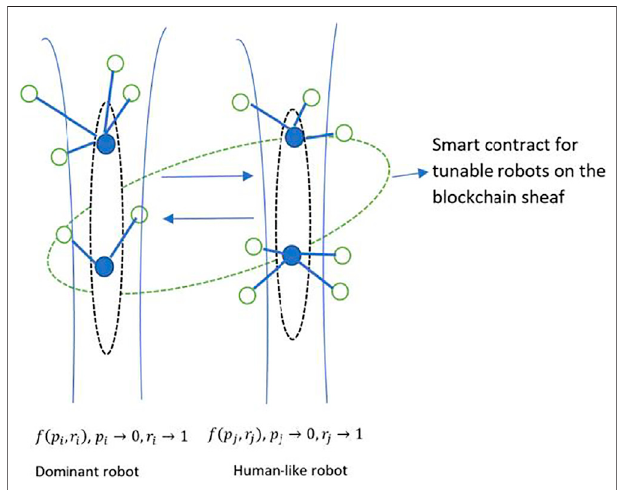
FIGURE 6 | Stalks representing social robots. Left: A controller robot. Right: A lower-level robot.